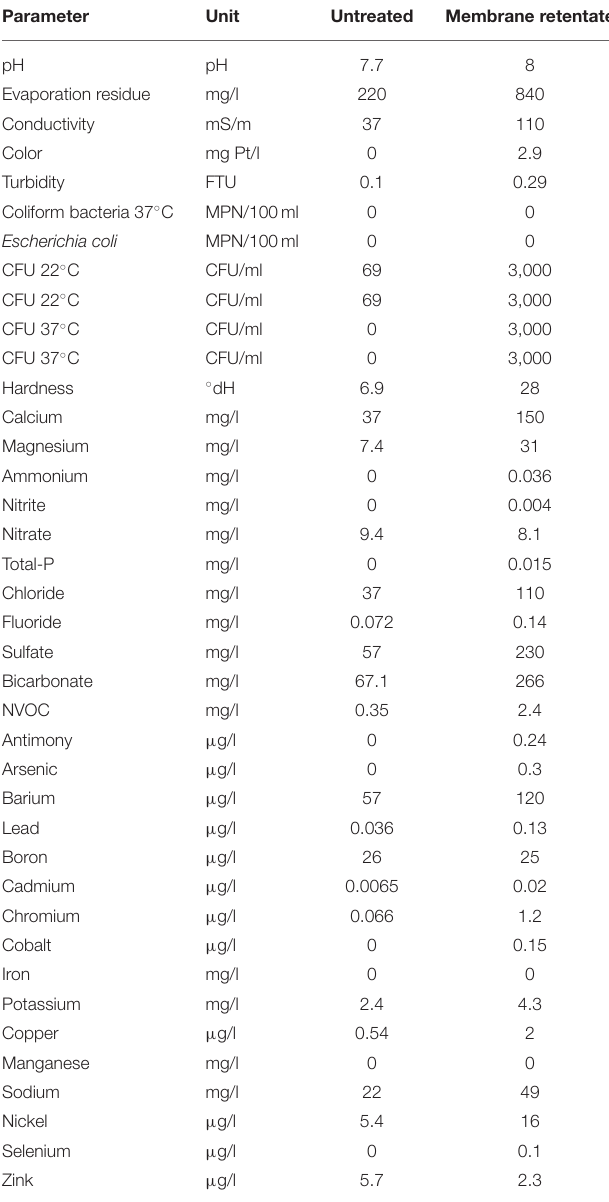
TABLE 1 | Characterization of the untreated DWTP water and membrane retentate water.